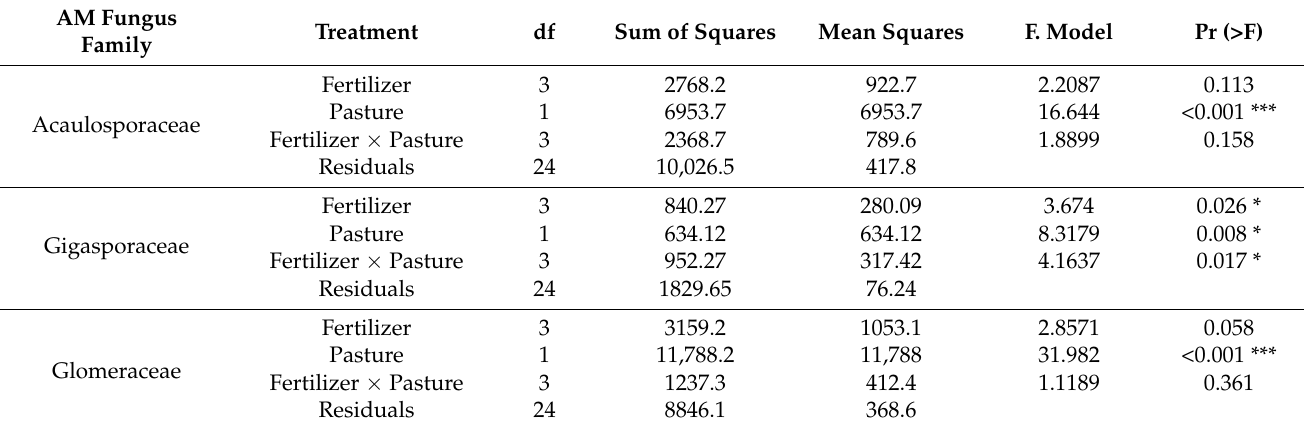
Figure 5. Relative abundance of mycorrhizal families for soils amended with a chemical fertilizer (CF), a rock mineral fertilizer (MnF), a microbial inoculant (Mic) and for an untreated soil (control) in the presence of subterranean clover ( Left ) and annual ryegrass ( Right ) at 10 weeks. Results are presented as means + standard errors. Table 4. Root AM fungi two-way ANOVA results showing p values fixed at family resolution of relative abundance. Treatments consisted of ‘Fertilizer’, and ‘Pasture’. Significant p values indicated by * and *** corresponding to p < 0.05 and < 0.001,